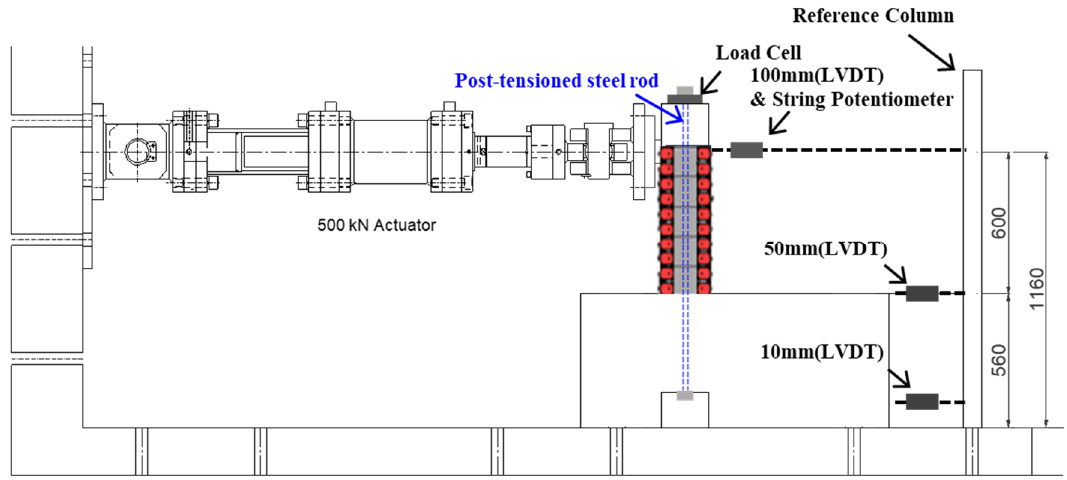
Figure 6. Test setup (unit: mm). Figure 7 indicates the location of strain gauges for longitudinal and transverse rebars.